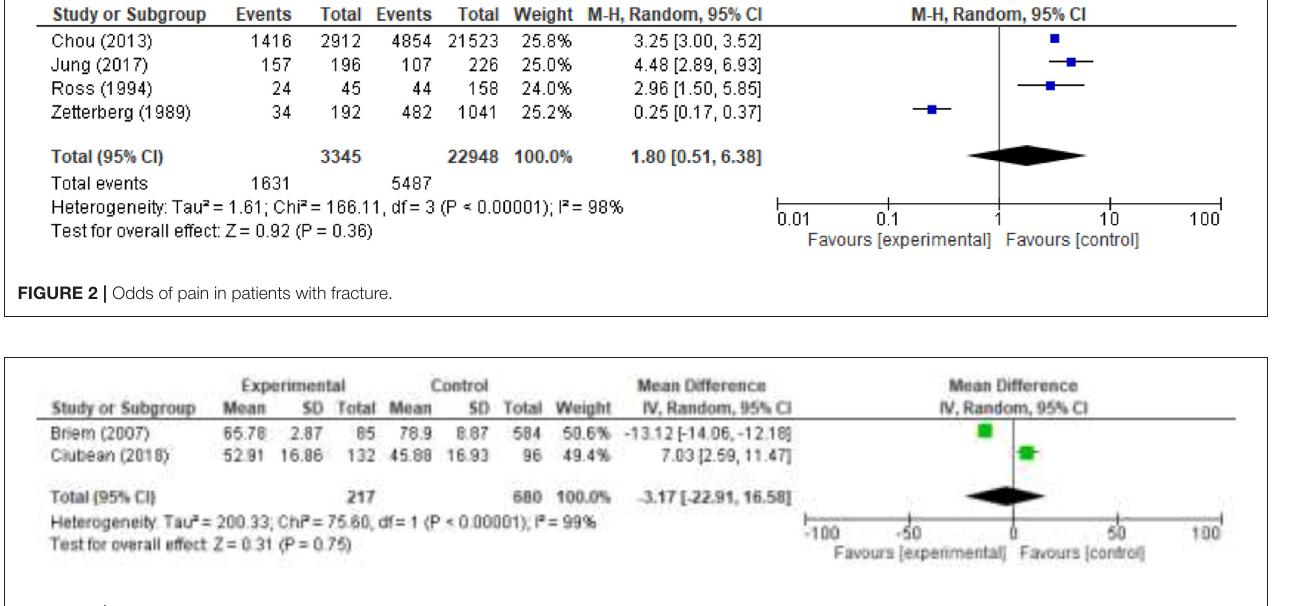
FIGURE 3 | Mean difference of pain in patients with fracture: SF-36 (pain/discomfort